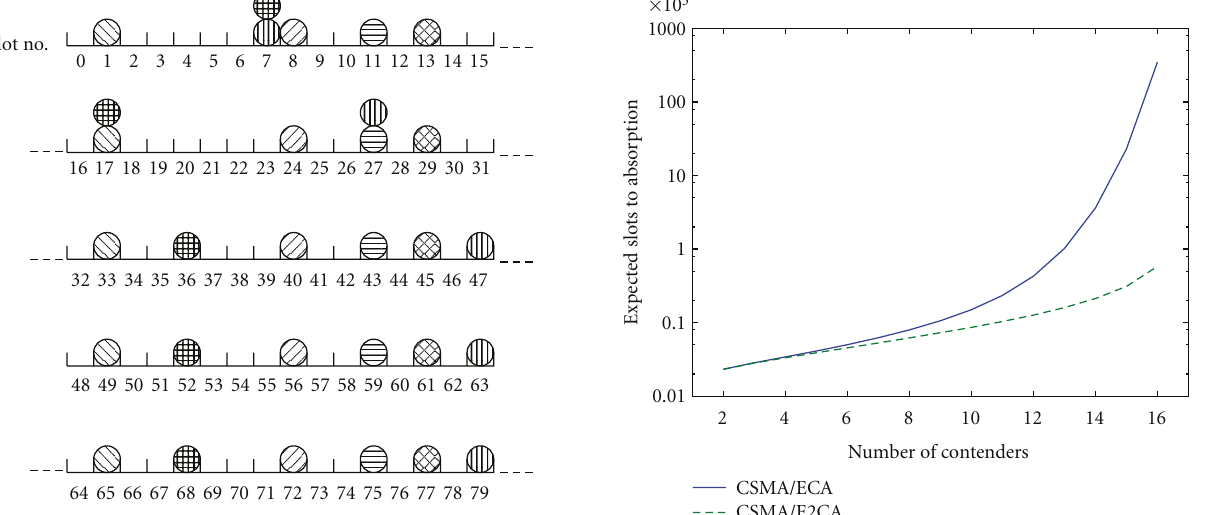
Figure 3: A graphical example of the execution of CSMA/E2CA. for two consecutive times after a successful transmission.